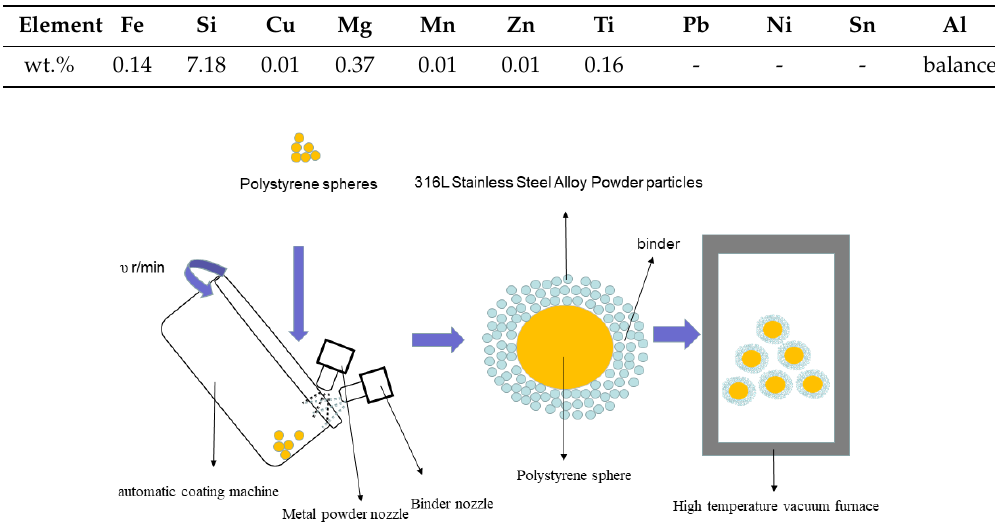
Table 1. The chemical composition of the A356 alloy.